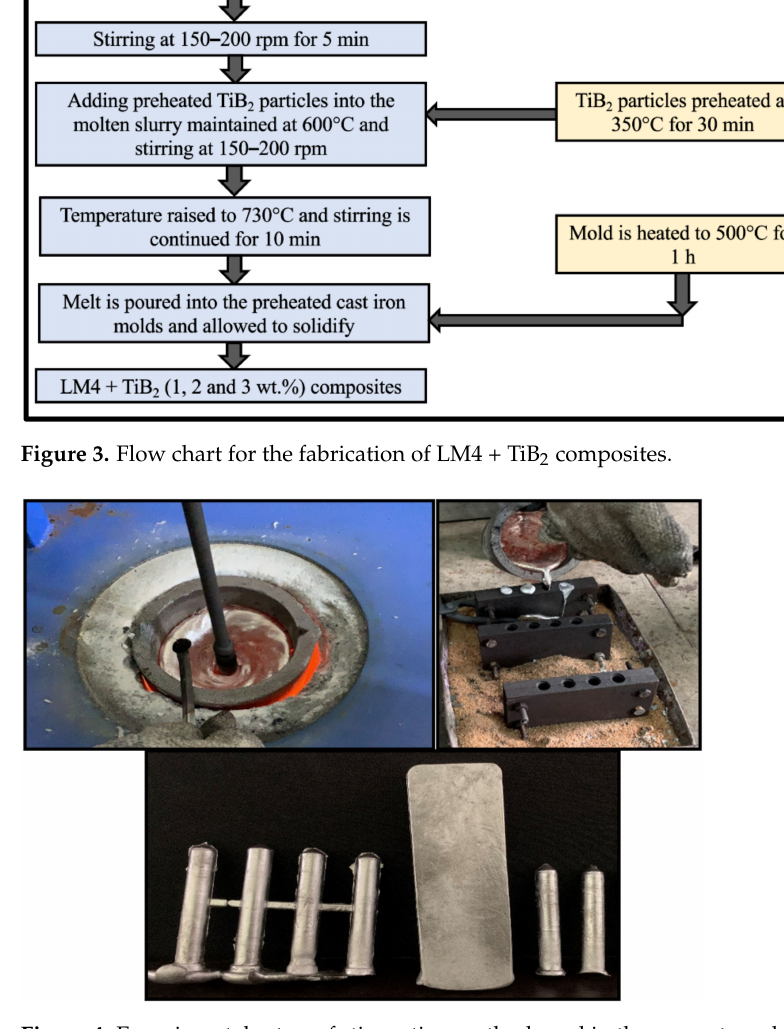
Figure 4. Experimental setup of stir-casting method used in the present